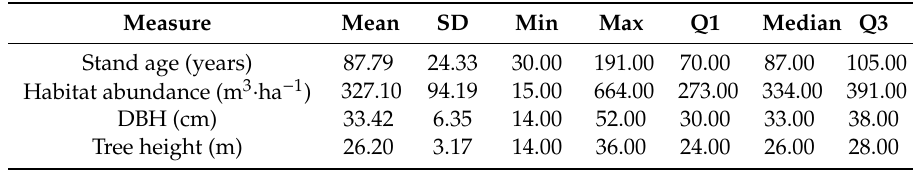
Table 1. Characteristics of the parameters of the origin of the